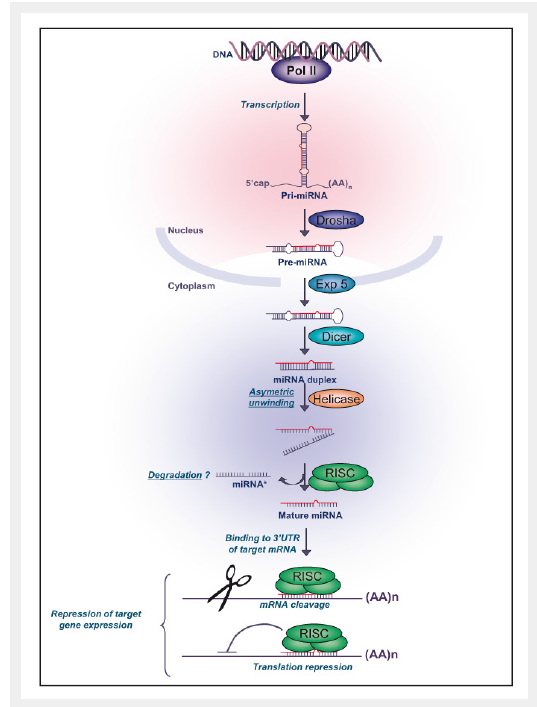
Figure 1: MicroRNA